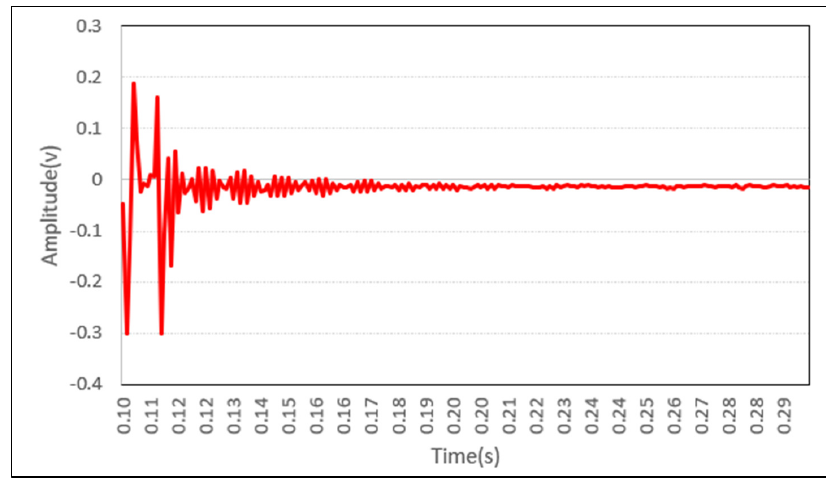
Fig. 11. Vibration Suppression and Time Response under FLC for Second Link .